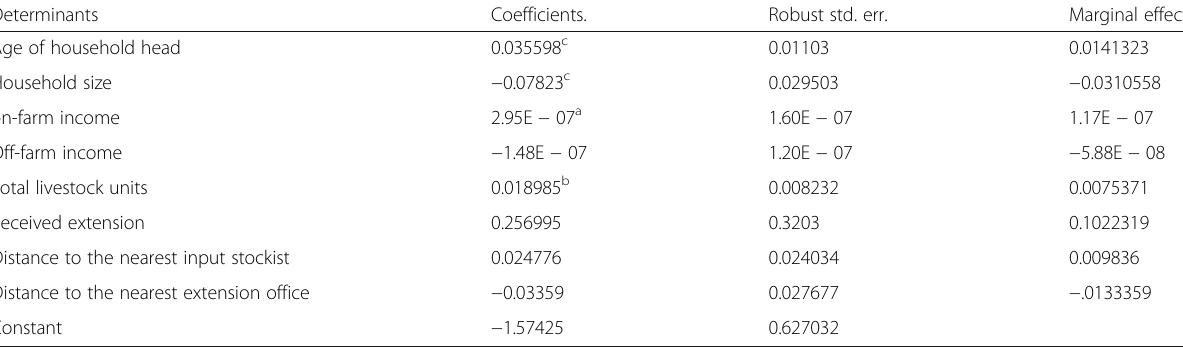
Table 3 Determinants of camel of production in Karamoja sub-region, Uganda Determinants Coefficients. Robust std.